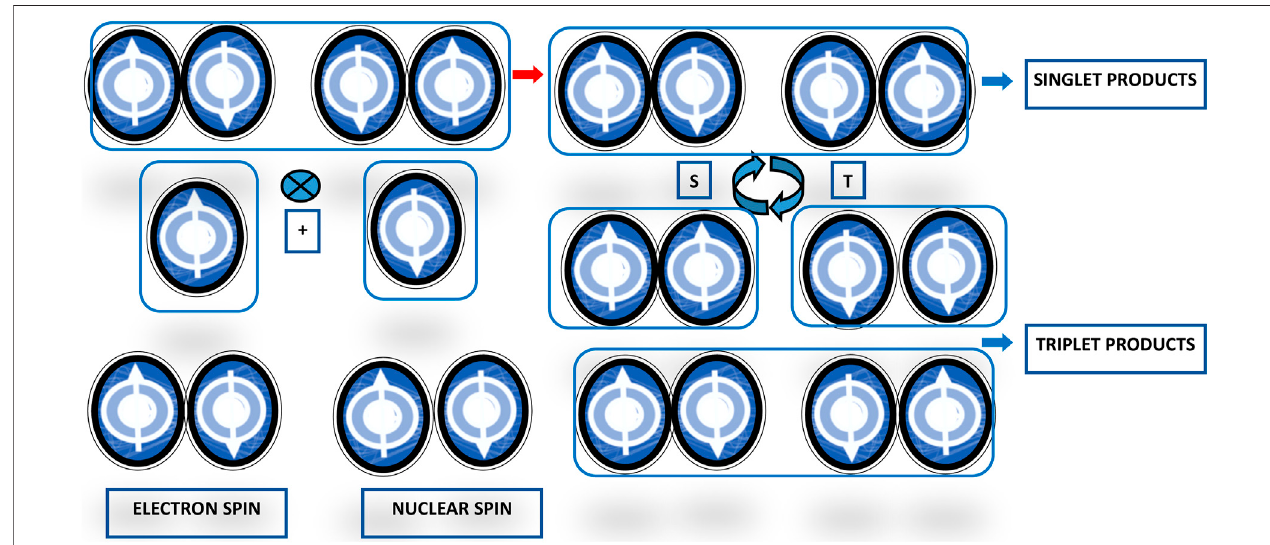
FIGURE 3 | Scheme representing the radical-pair reaction mechanism for avian magnetoreception. The basic reaction scheme of the magnetoreception in birds encompasses lightabsorptionby and chemical reactionofthe radical pair inCryptochrome molecules inthe eyes. Activation by photons withadequate energy elicitsan electrontransferreactionproducingtheradicalpairsintheirexcitedsingletstates.Thestateofthepaircanremaininasingletstateorbecomeatripletstate,withdifferent singlet- and triplet-state ratios depending on the geomagnetic fi eld in fl uence.